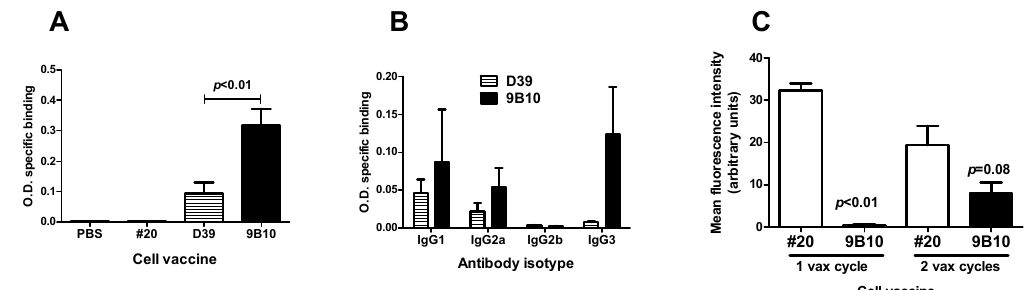
Figure 3. Anti-IGF1R and anti-HER2/neu antibodies elicited by cell vaccines co-targeting HER2/neu and IGF1R. ( A ) Anti-mIGF1R antibodies determined by indirect Elisa assay. Sera were collected from BALB-p53Neu mice after two vaccination cycles and diluted 1:400. Statistical significance (Student’s t test) of difference between D39 ( n = 8) and 9B10 ( n = 6) is reported in the figure. ( B ) Analysis of antibody isotypes induced by cell vaccines as in figure 3A ( n = 3 mice per group). ( C ) Anti-rat HER2/neu antibodies induced in HER2/neu transgenic mice after one or two vaccination cycles and evaluated by indirect immunofluorescence against N10F2.1 target cell (mean fluorescence intensity for rat HER2/neu of 70 arbitrary units). Statistical significance (Student’s t test) vs. #20 is reported in the figure ( n = 3 for each group).